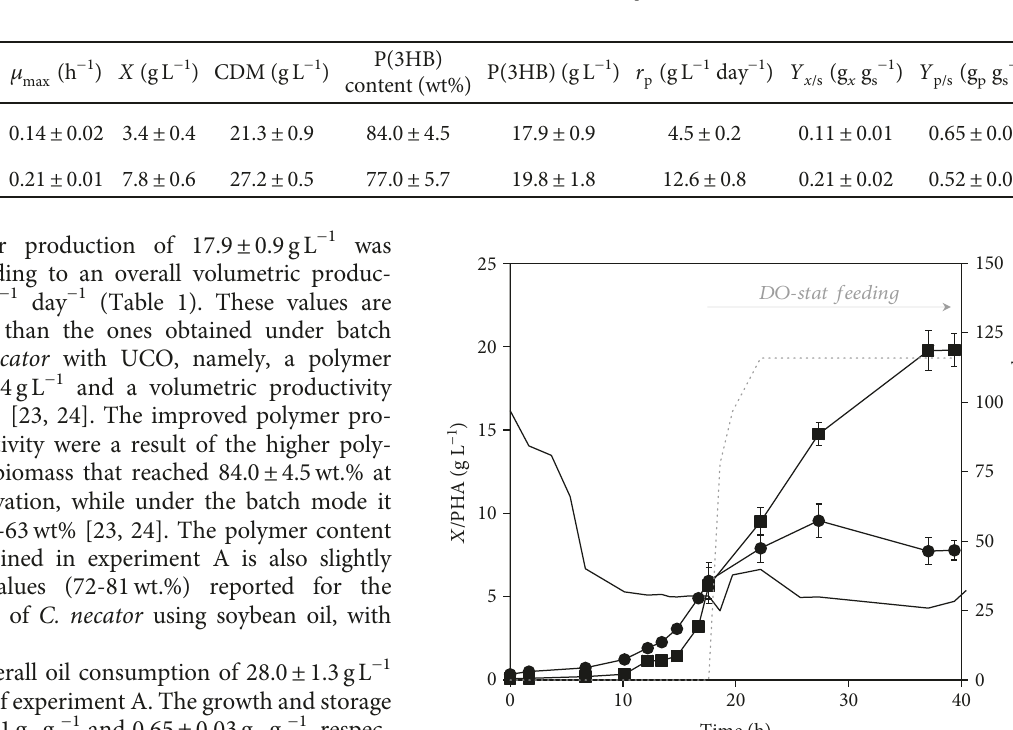
: maximum speci fi c cell growth rate; X: active biomass; CDM: cell max : volumetric productivity; Y : growth yield; p x /s